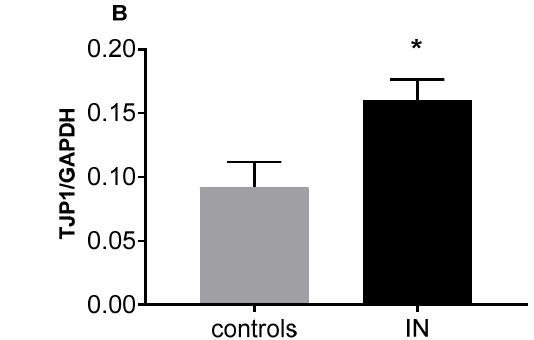
Figure 2. Mean levels of Advanced Glycated End-products, AGEs ( A ) and of Tight junction protein-1 (TJP1) gene expression ( B ) in mucosal samples from CD patients in the control and IN groups. * p < 0.05 by unpaired t test. UA = Arbitrary Unit.